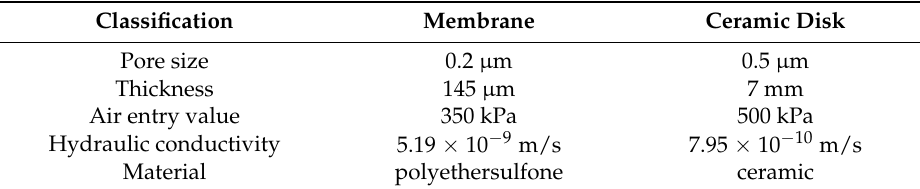
Table 2. Specifications of the membrane and ceramic